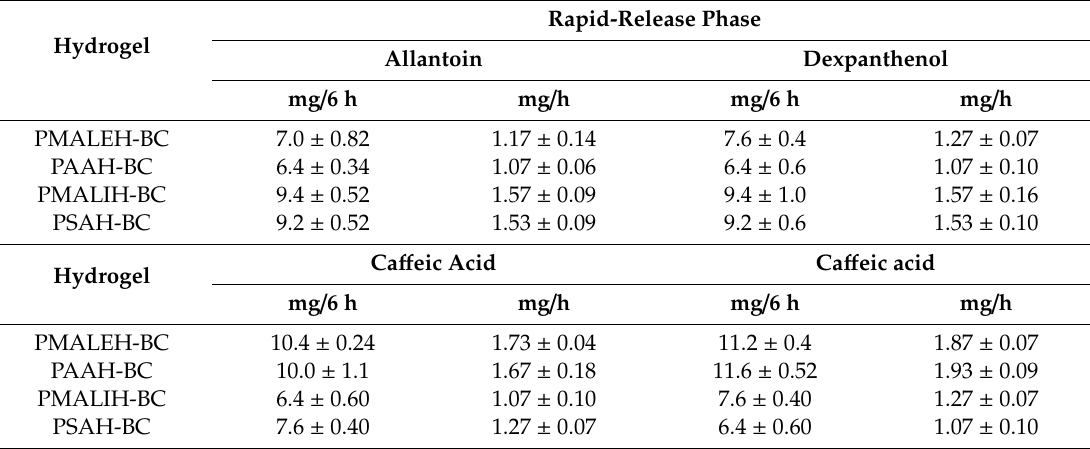
Table 4. The average release rate during the rapid-release phase.